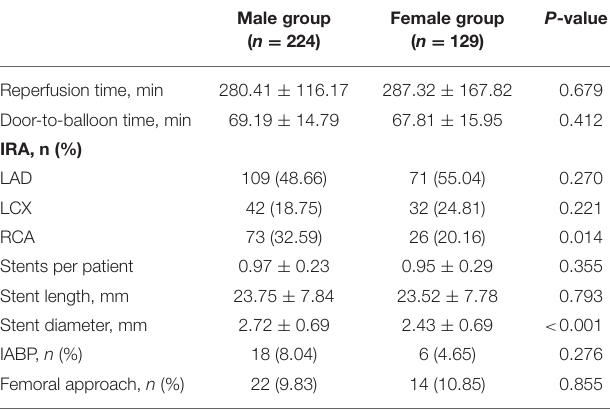
TABLE 2 | Primary angiographic and interventional therapy characteristics.